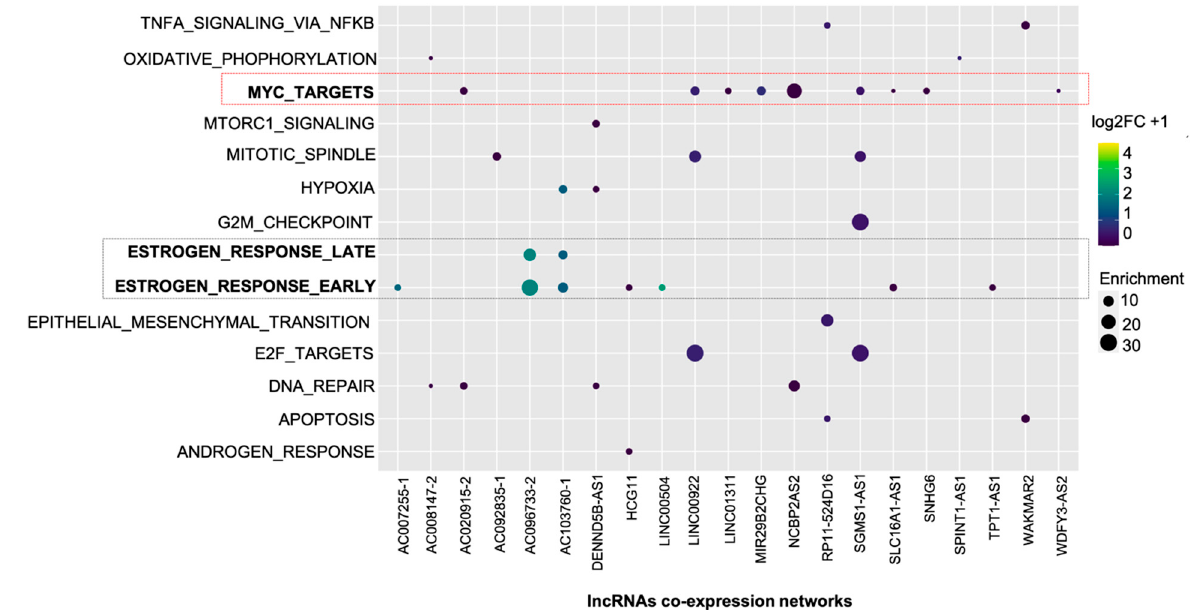
Figure 2. Enrichment map of the identified co-expression networks. In rows are the 14 identified molecular signatures, and in the columns, the networks of co-expression of 21 lncRNAs. Dot size refers to the number of genes identified in each cancer-related process. Blank spaces mean that there was no statistically significant enrichment. Dot color refers to the difference (logFC + 1) of the lncRNAs used as a reference for building co-expression networks. The comparison was made between luminal A and basal-like, with dots with colors closer to yellow more expressed in luminal subtype A. Colors closer to purple indicate down-regulation in luminal A. In this enrichment map, the pathway named “MYC_TARGETS” (red rectangle) and “ESTROGEN_RESPONSE_EARLY” (black rectangle) stands out as the most frequently identified.